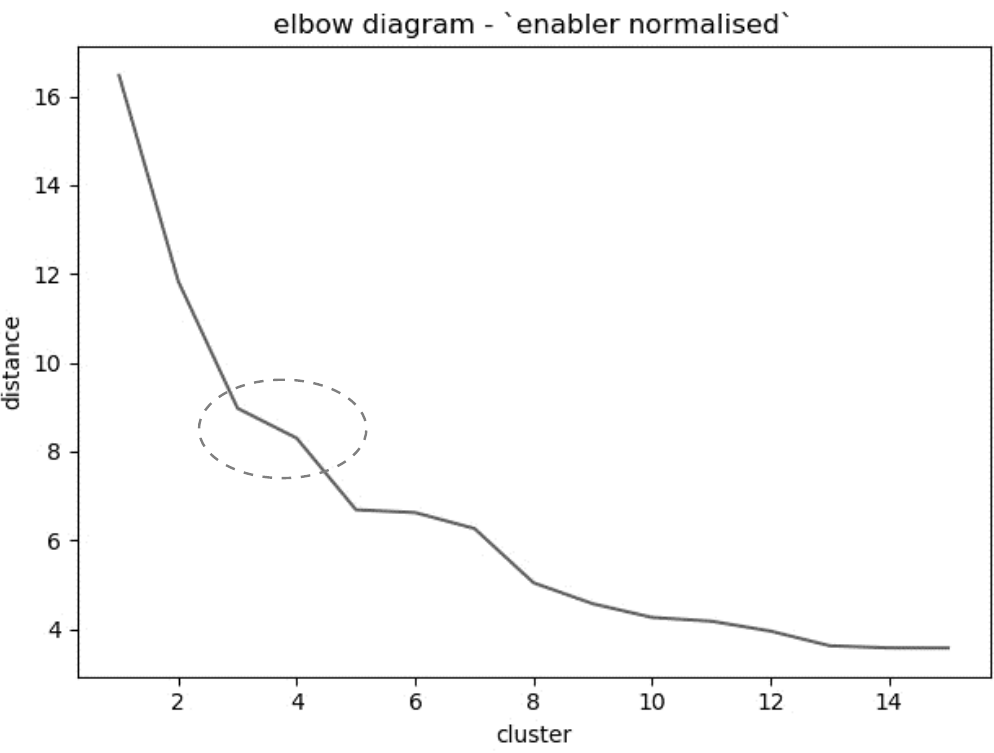
Figure 5. Elbow diagram for all candidates for all COBIT